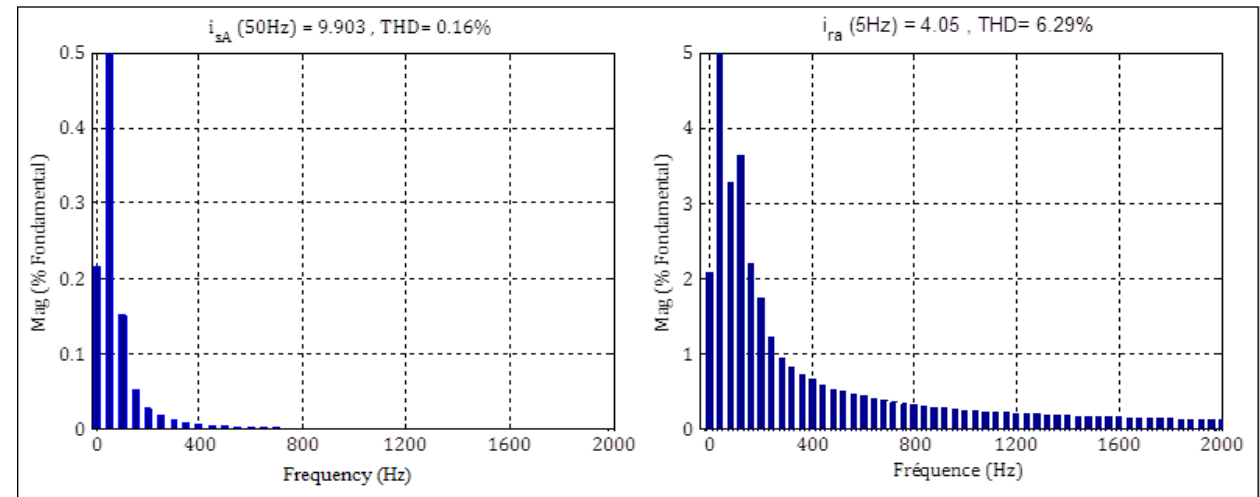
Figure 4 present the THD for current and voltage.